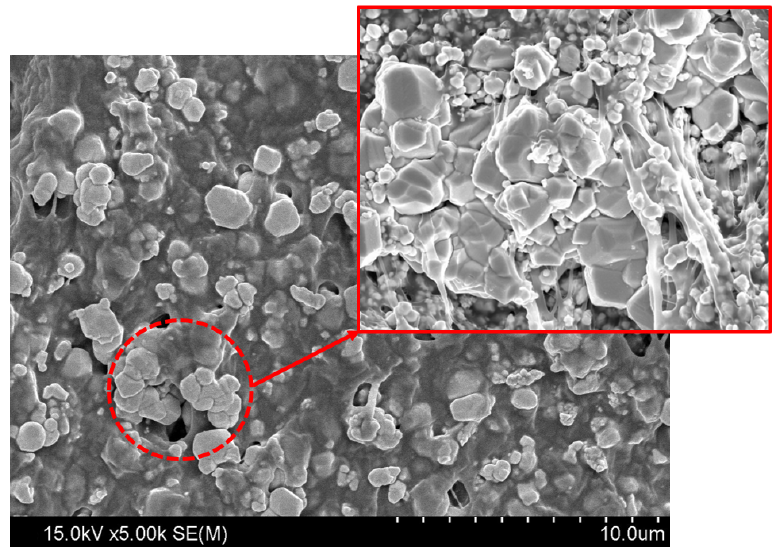
Figure 4. Morphology of the film in which emulsion polymers are mixed with tungsten. Clearly, the tungsten particles can be seen to agglomerate.